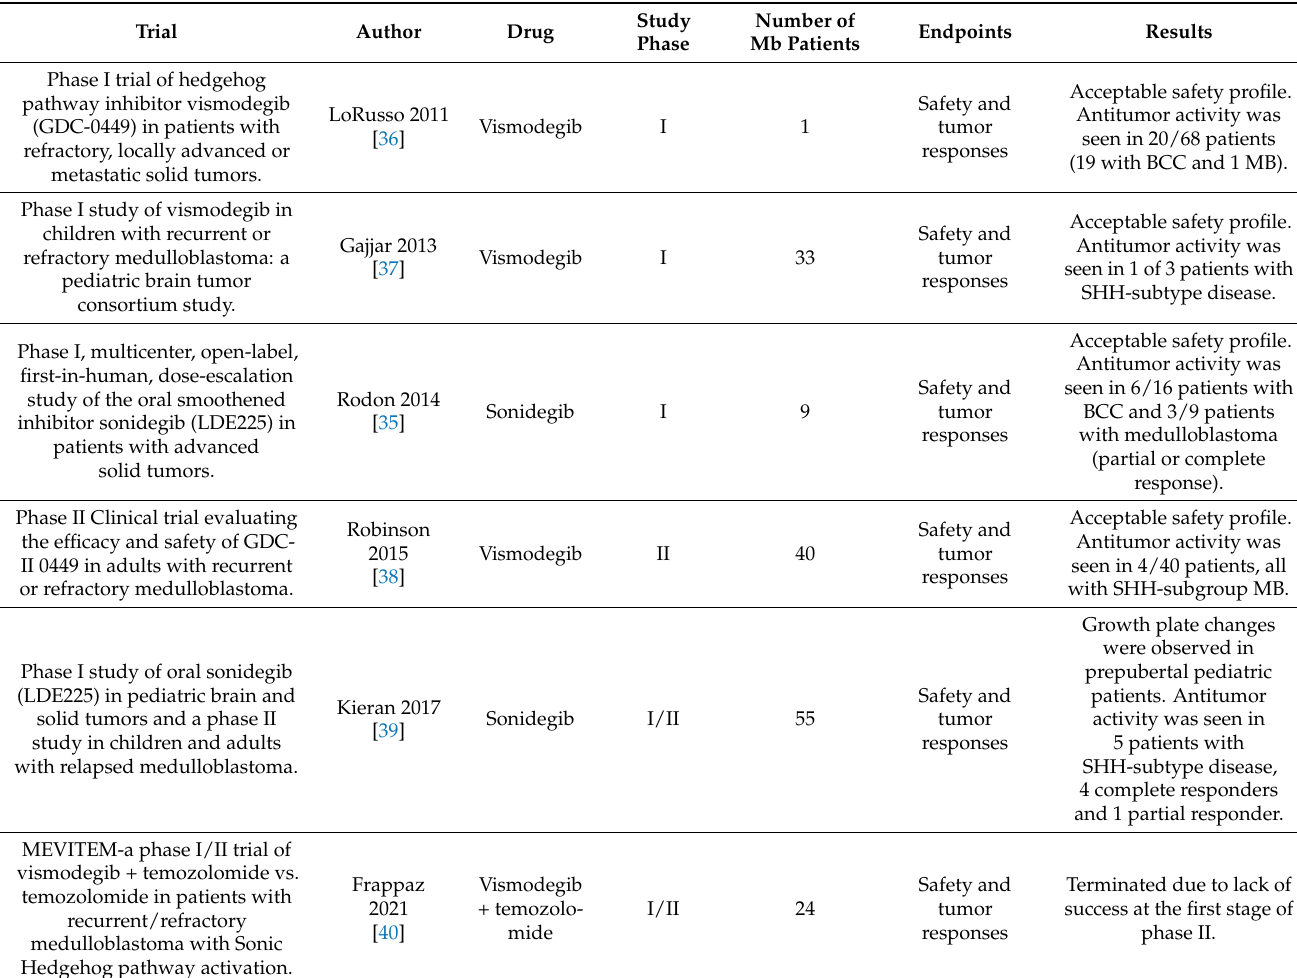
Table 1. Completed clinical trials exploring targeted therapies for SHH-MB